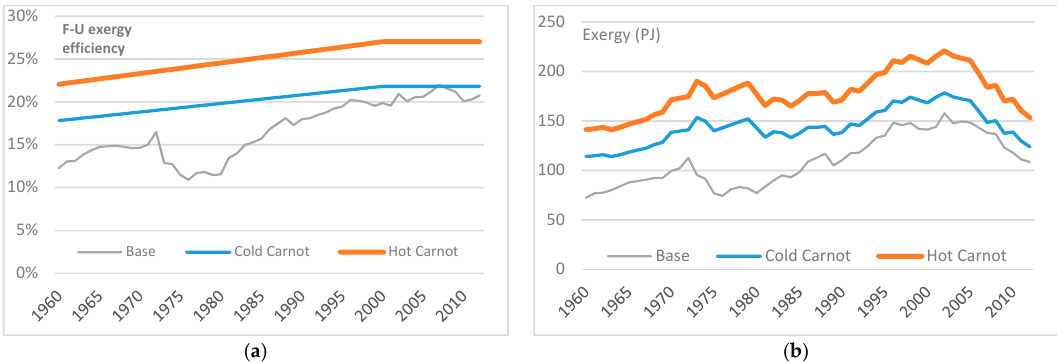
Figure 10. Medium-temperature industrial heat ( a ) end-use exergy efficiency and ( b ) useful exergy.